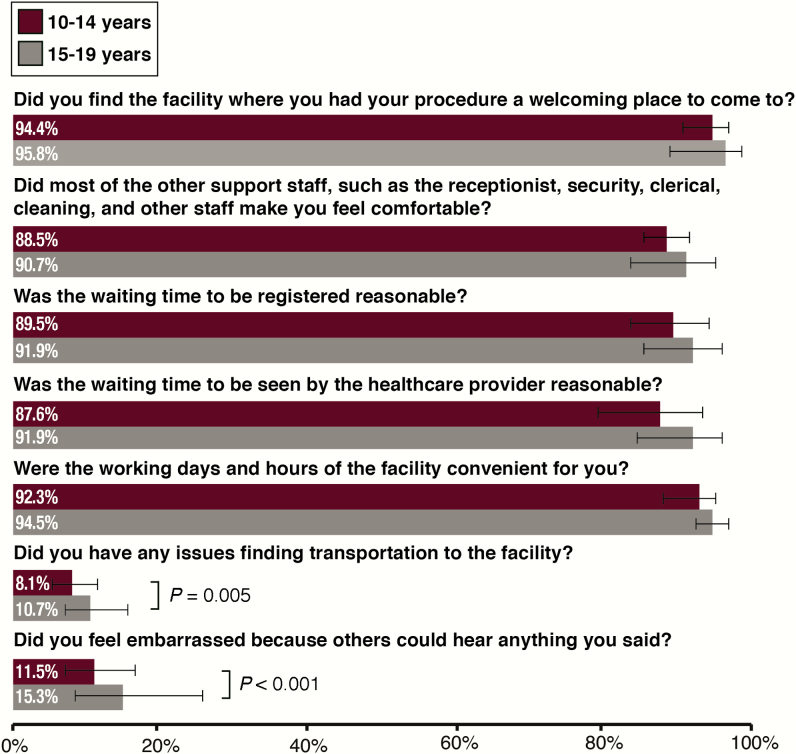
Adolescent perceptions of facility-level factors of service delivery. Proportions reflect a response of “yes.” 95% confidence intervals were estimated by Taylor series linearization. P values were calculated from modified Poisson regression models with generalized estimating equations and robust variance estimation; models were adjusted for country. P values >.05 are not shown.